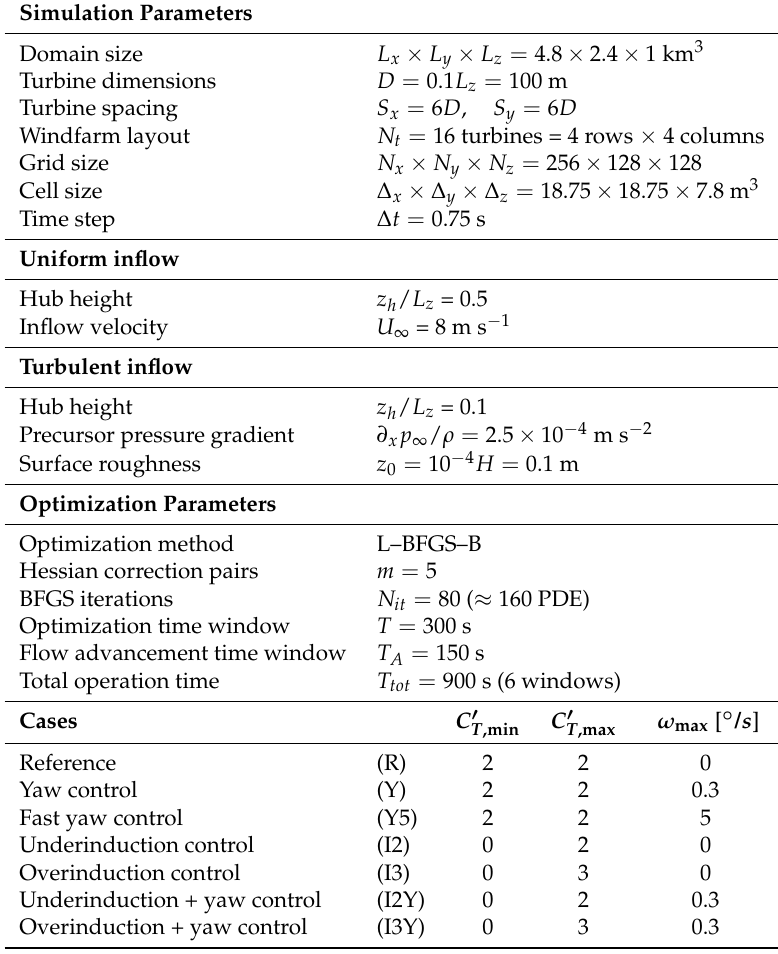
Table 1. Setup parameters for optimal dynamic induction and yaw control